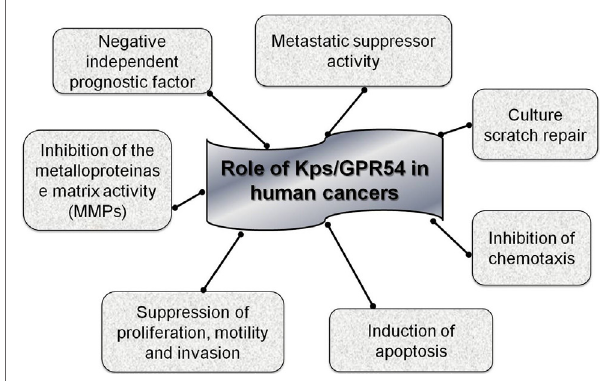
FiGURe 2 | Kps/GPR54 in human